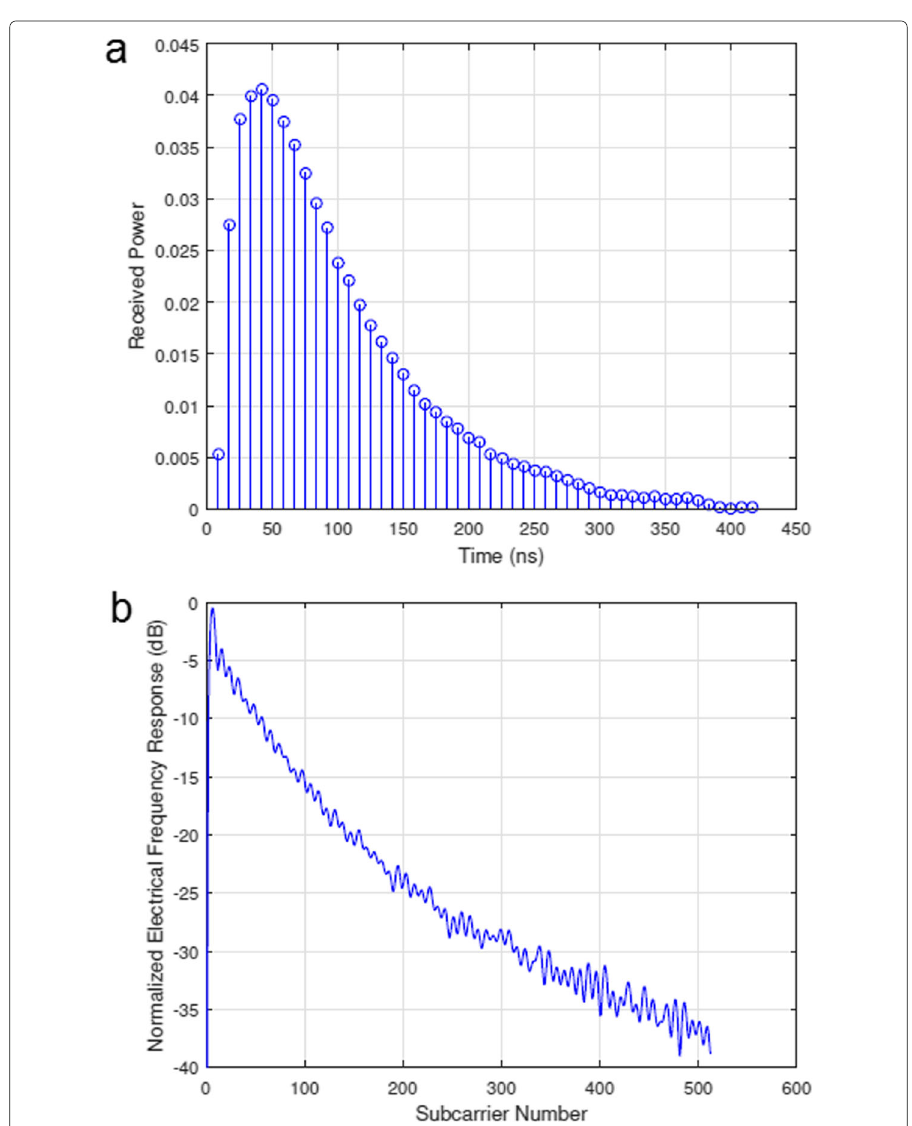
Fig. 15 Estimated a impulse and b frequency responses of the VLC channel at the output of the receiver